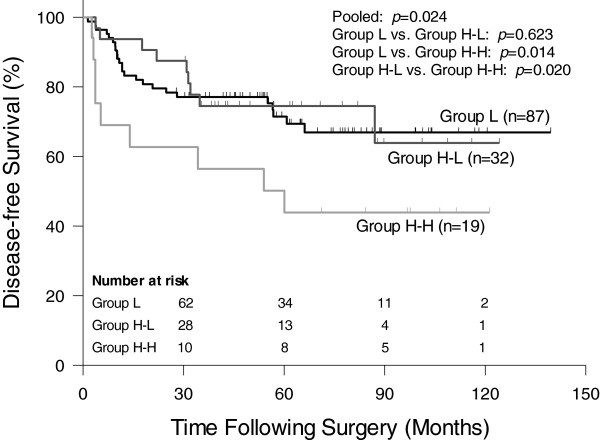
Comparison of disease-free survival between group L, H-L and H-H. Group L: pre-CRT CEA <6 ng/ml; Group H-L: pre-CRT CEA ≥6 ng/ml and post-CRT CEA <6 ng/ml; Group H-H: both pre- and post-CRT CEA ≥6 ng/ml.